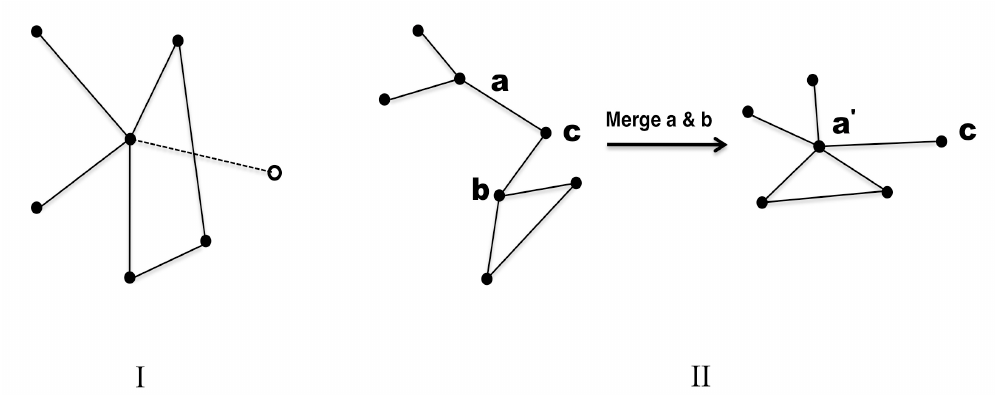
Fig. 2. A diagram illustrating the two operations in the model. (I) attachment, where a new vertex is added to the graph and it is connected to an old vertex by an edge; (II) merging, where vertices a and b are merged into vertex a have a comment neighbor, c in this case, after the merging only one edge remains between a